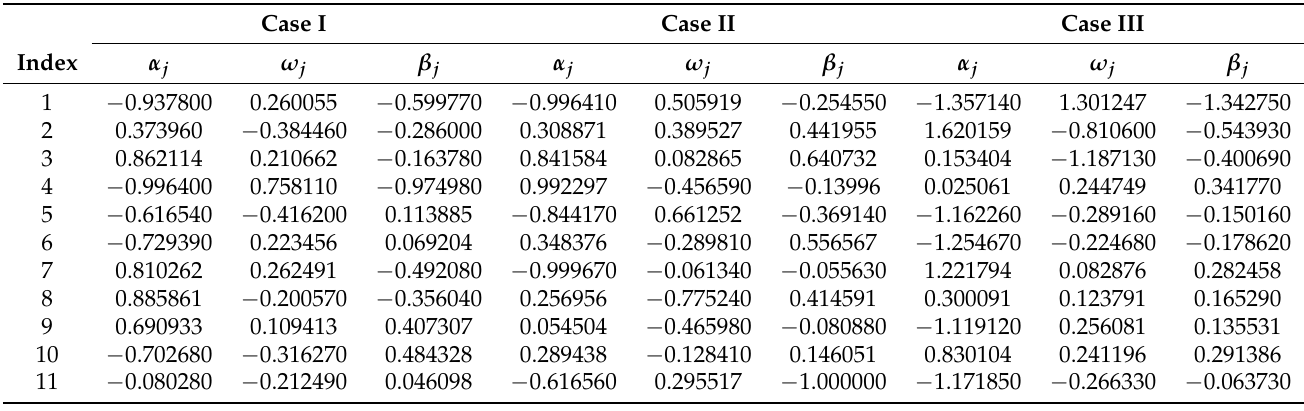
Table 10. Best set of weights obtained by the LNN-GNDO-SQP algorithm using a fitness function as in Equation (55). Here three cases are studied by varying a in the drainage